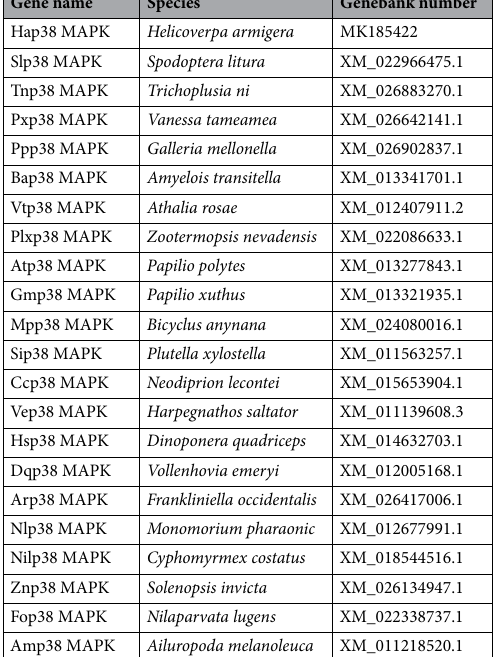
Table 1. Names and accession numbers of genes used in the phylogenetic tree